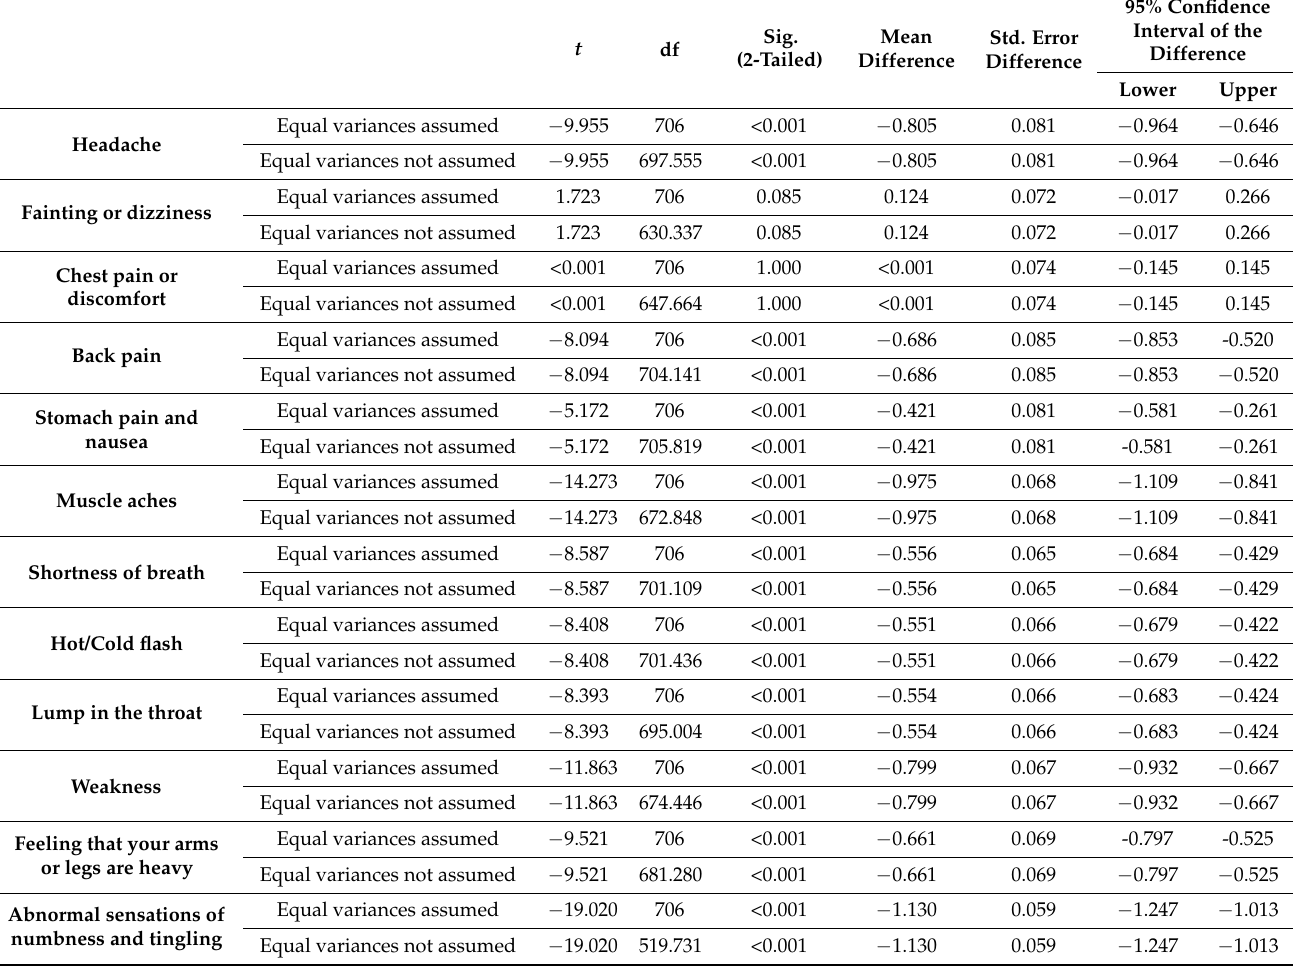
Table 8. Correlation between psychometric parameters before and during the SARS-CoV-2 lockdown period.